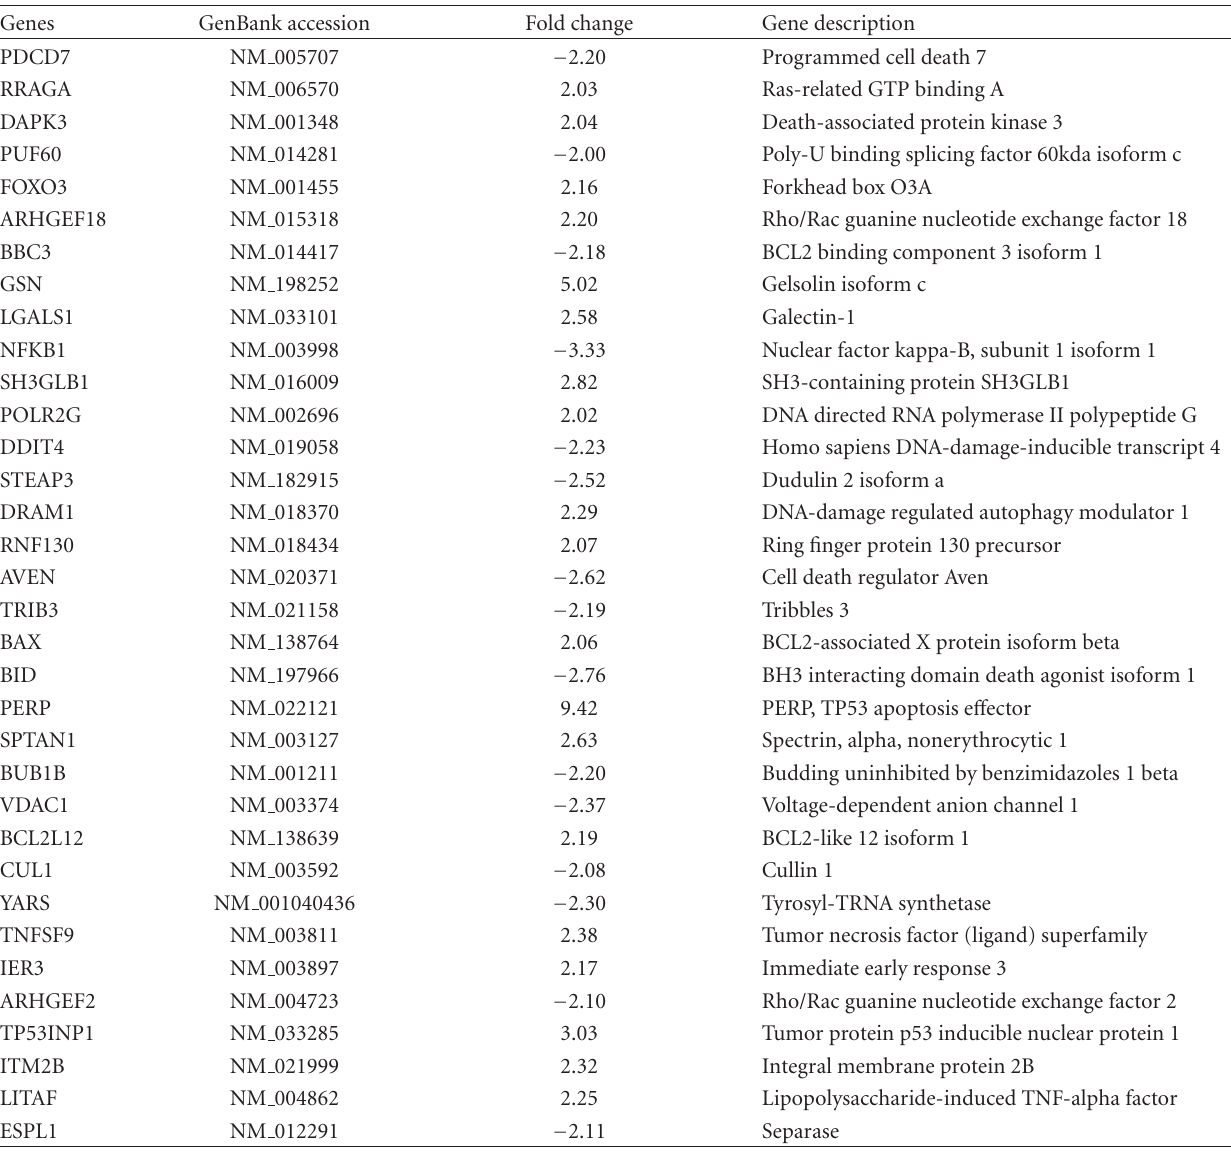
Table 2: Di ff erentially expressed genes involved in apoptosis detected by significant enrichment analysis of GO terms using the R language software